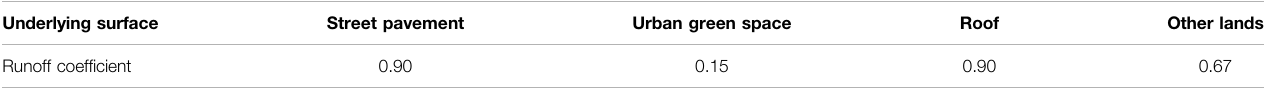
TABLE 3 | Reference table for runoff coef fi